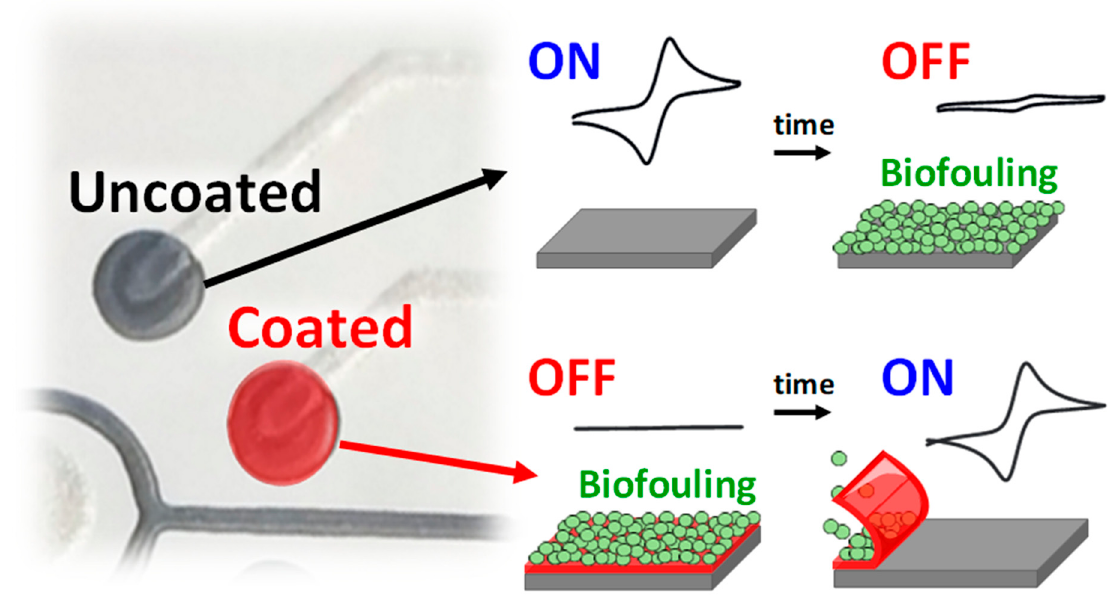
Figure 2. Schematic display of the methodology involving the use of biocompatible pH-sensitive transient polymer coatings to impart electrochemical biosensor antibiofouling properties. Figure drawn based on [22].